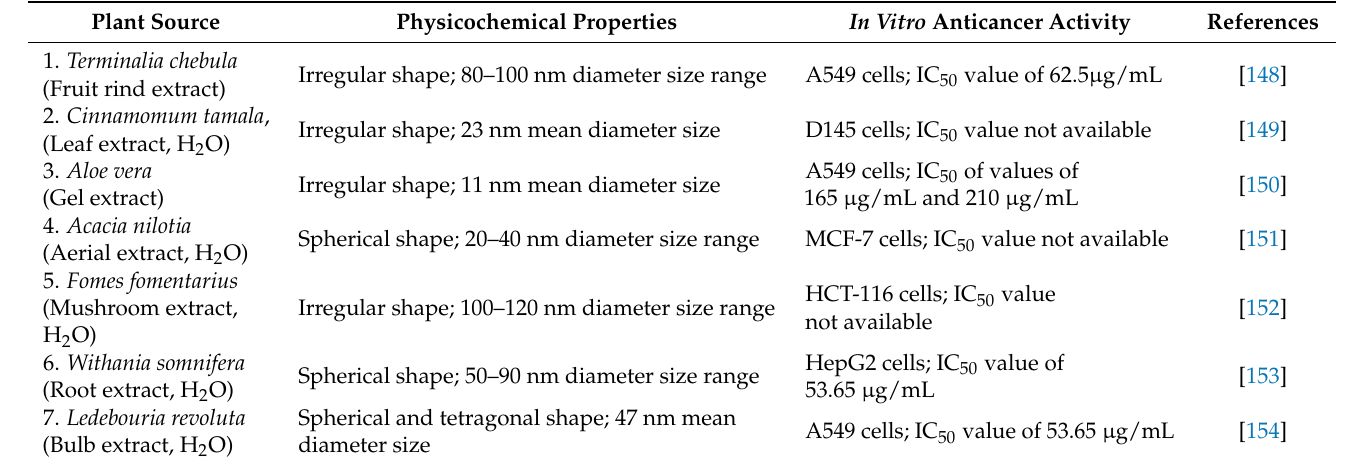
Table 4. Anticancer activity of various biosynthesized titanium oxide